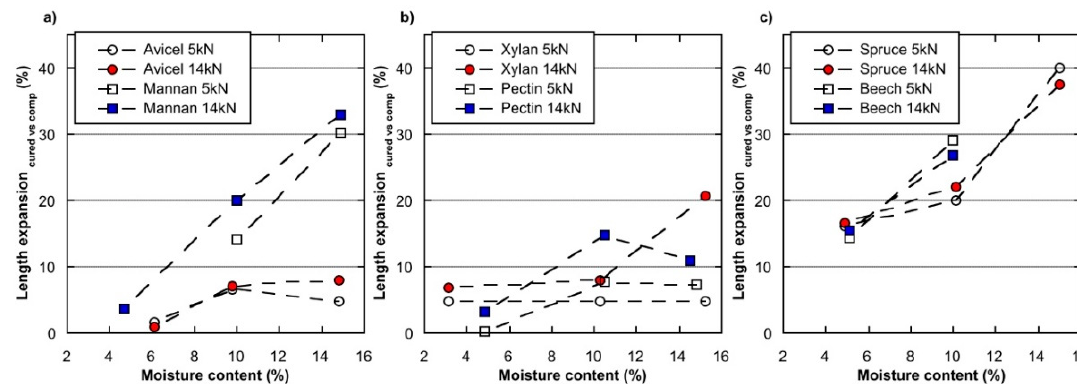
Figure 5. Length expansion for cured pellets in comparison with compressed pellets for up to 5 kN and 14 kN at a varied moisture content: a) Stiffer polysaccharides cellulose and mannan, b) more flexible polysaccharides xylan and pectin, and c) softwood and hardwood.